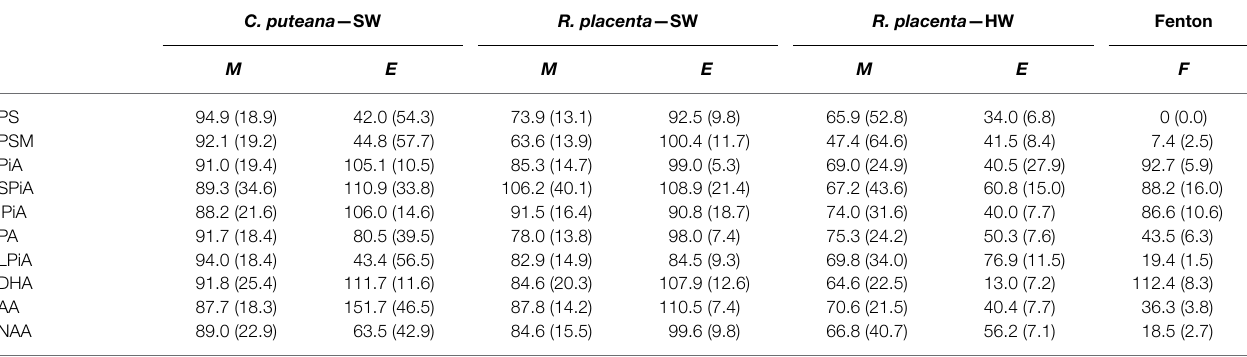
TABLE 1 | Average concentrations (as % of reference) of individual stilbenes and resin acids in the heartwood extract after incubation with mycelium (M) or extracellular culture fluid (E) from C. puteana and R. placenta cultures supplemented with sapwood (SW) or heartwood (HW) powder, or with Fenton